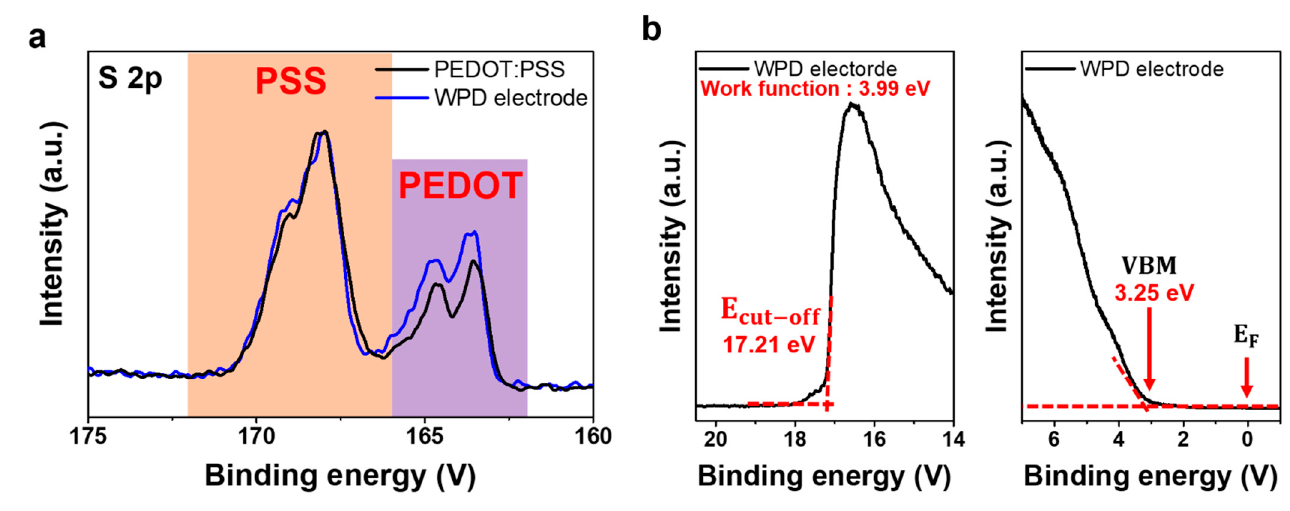
Figure 4. ( a ) The XPS analysis of the PEDOT:PSS and the WPD electrode; ( b ) the UPS analysis of the optimized WPD electrode.